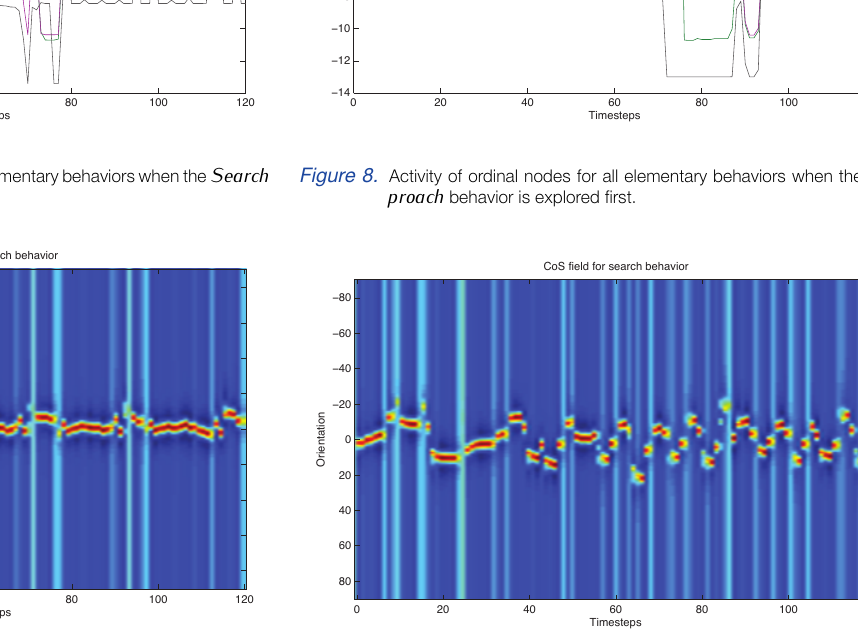
Figure 7. Activity of the CoS field for the Search behavior when the search behavior is explored first.